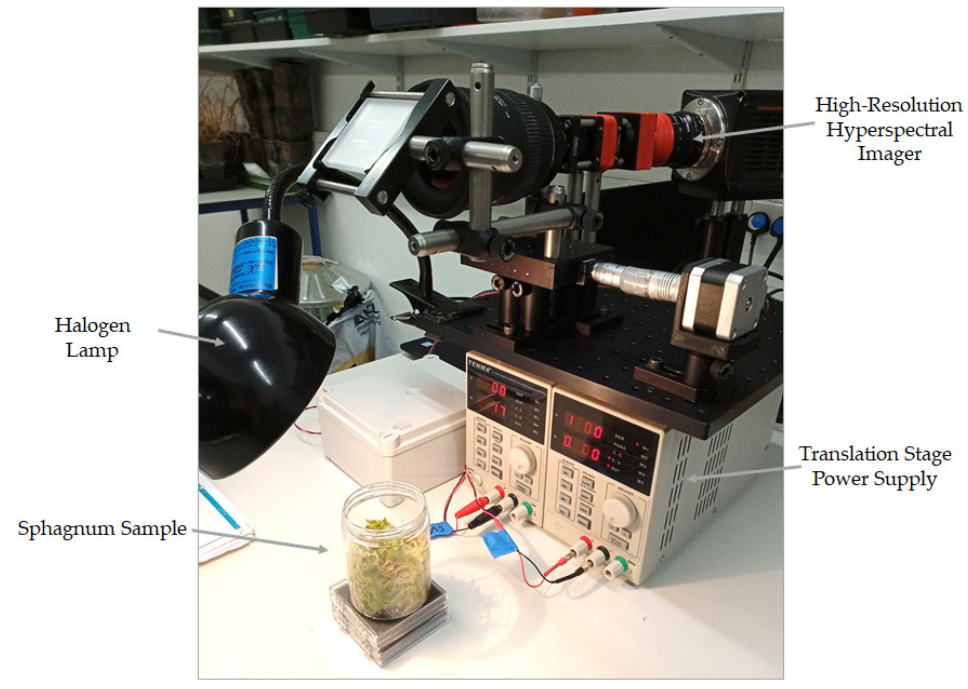
Figure 4. The Low-Cost High Resolution instrument set-up for Sphagnum sample analysis.